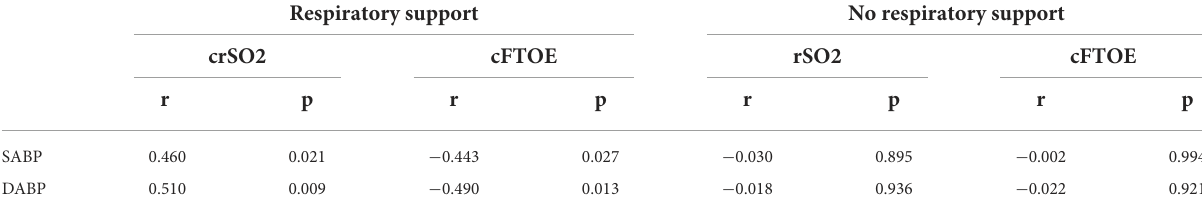
TABLE 3 Correlation analyses of crSO2 and cFTOE with blood pressure 15min after birth in preterm neonates with and without respiratory support. Respiratory